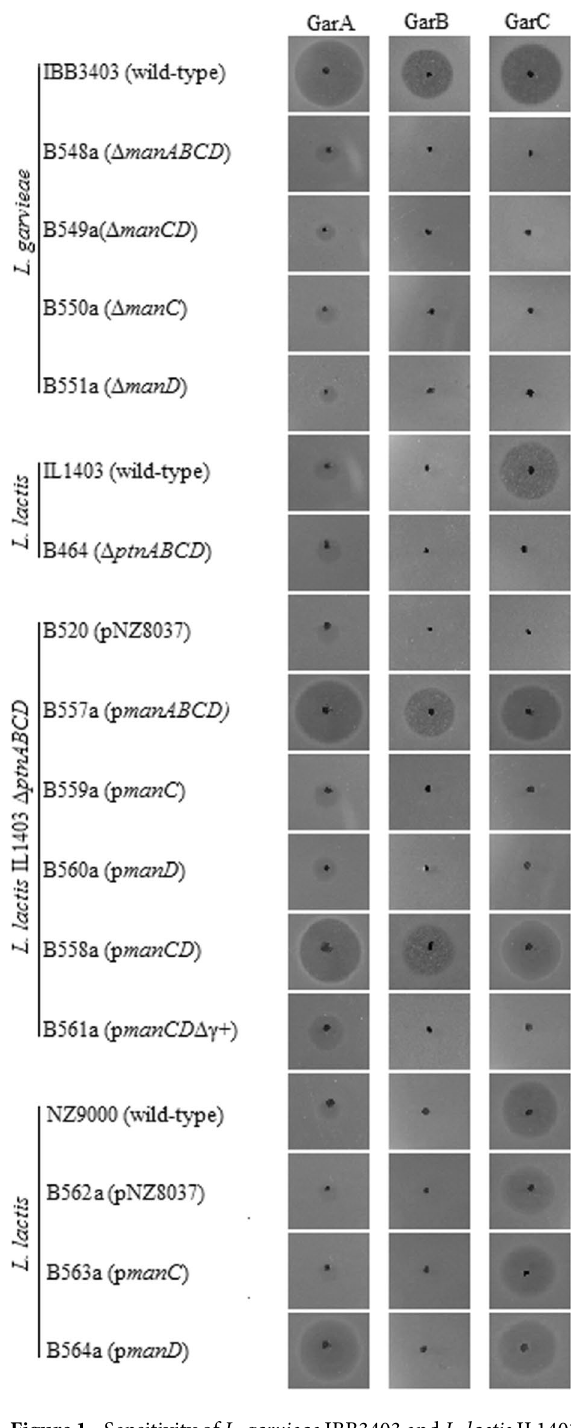
Figure 1. Sensitivity of L . garvieae IBB3403 and L . lactis IL1403 strains to GarA, GarB and